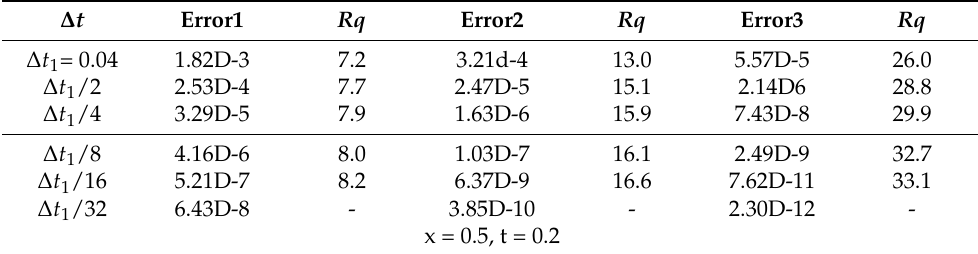
Table 2. Time accuracy